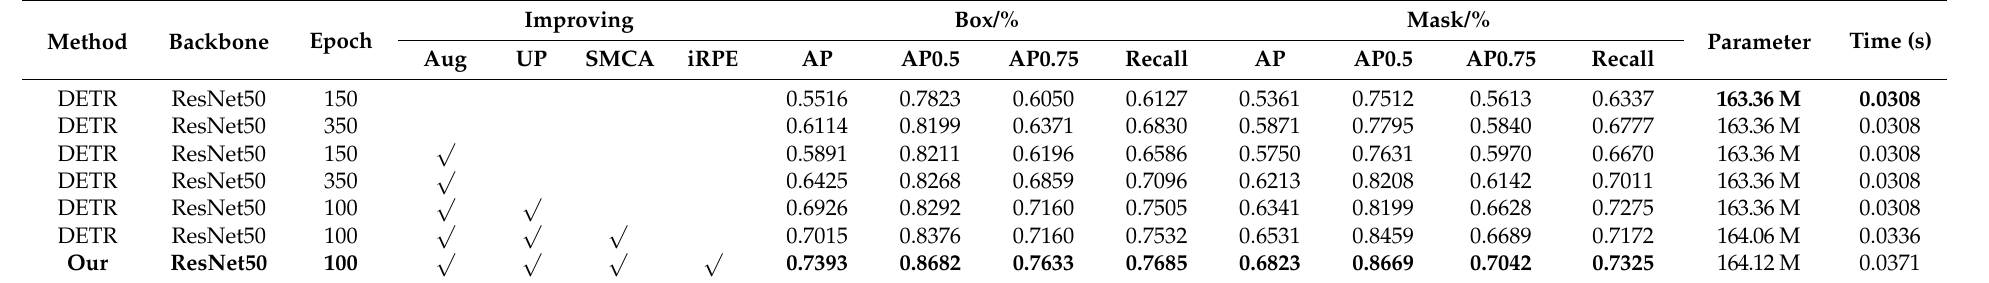
Table 1. Average precision bounding boxes (AP box ), average precision segmentation (AP mask ), runtime per image, and model parameter of DS-DETR in tomato disease spot and leaf.